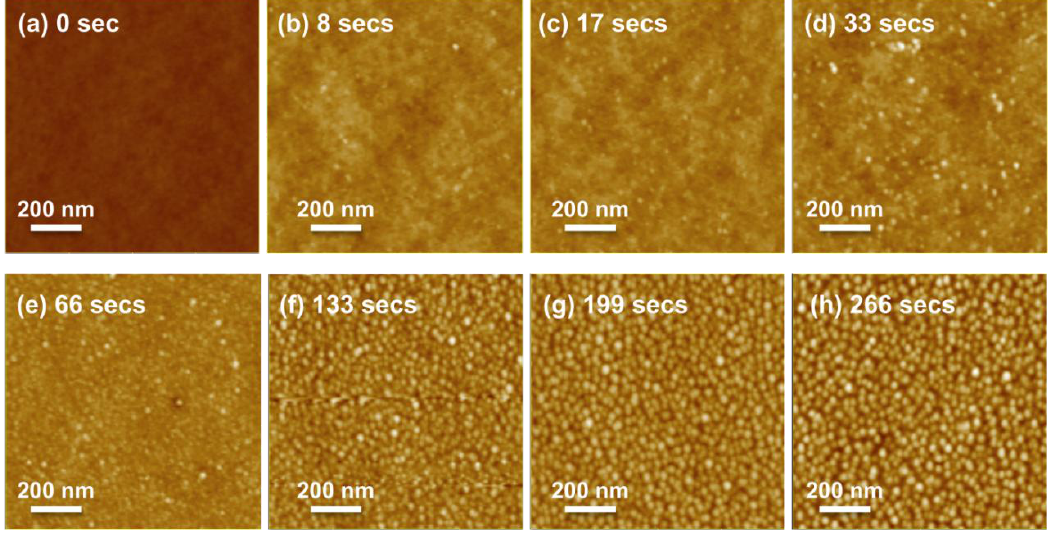
Figure 1. AFM images of Ar/O etched PS with bias voltage of −10 V and different etch 2 times from (a) 0 seconds to (h) 266 seconds, corresponding to approximate etch depths ( a ) 0 nm, ( b ) 9 nm, ( c ) 18 nm, ( d ) 35 nm, ( e ) 70 nm, ( f ) 142 nm, ( g ) 212 nm and ( h ) 284 nm. Roughness features (white spots) of uniform size (~20 nm) and form initially increase in number over time during plasma etching, and subsequently increase in amplitude without further increase in